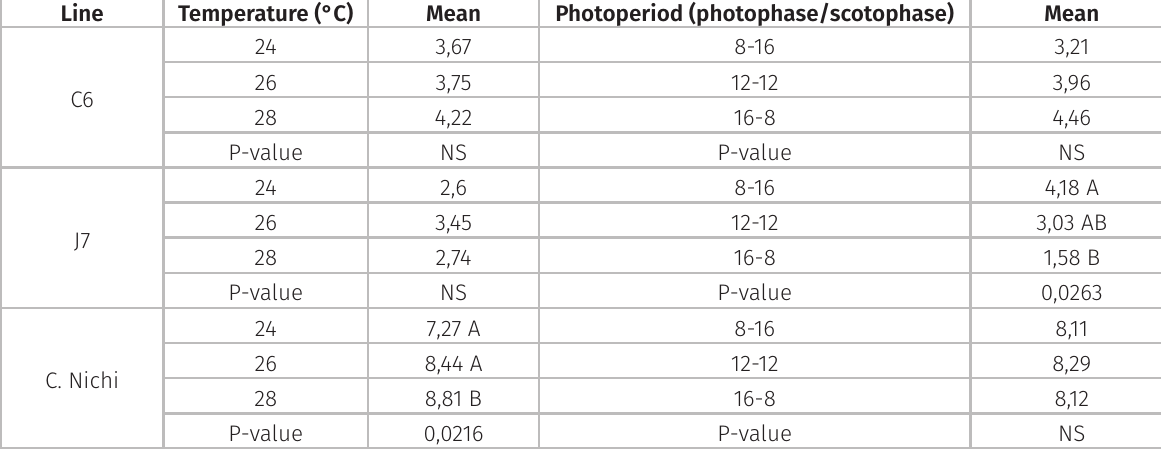
Table VI. Effect of temperature and photoperiod on voltinism. Means with different letter differ statistically at p<0.05. NS: Non-significant